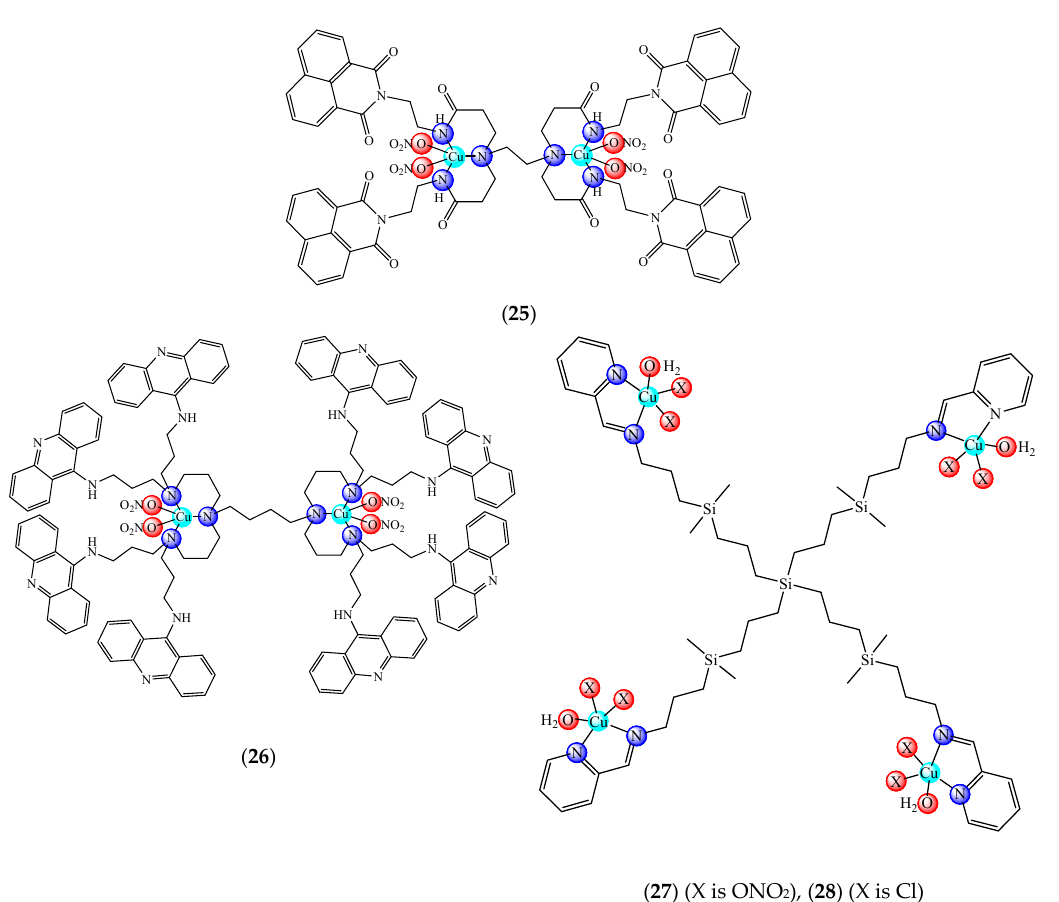
Figure 2. Bioactive dendrimeric complexes ( 25 )–( 28 ).